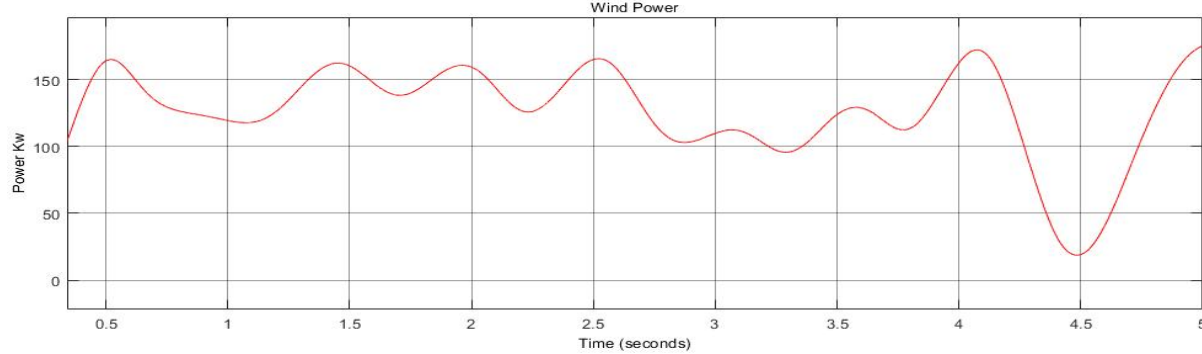
Figure 10. Generated power from the wind turbine.